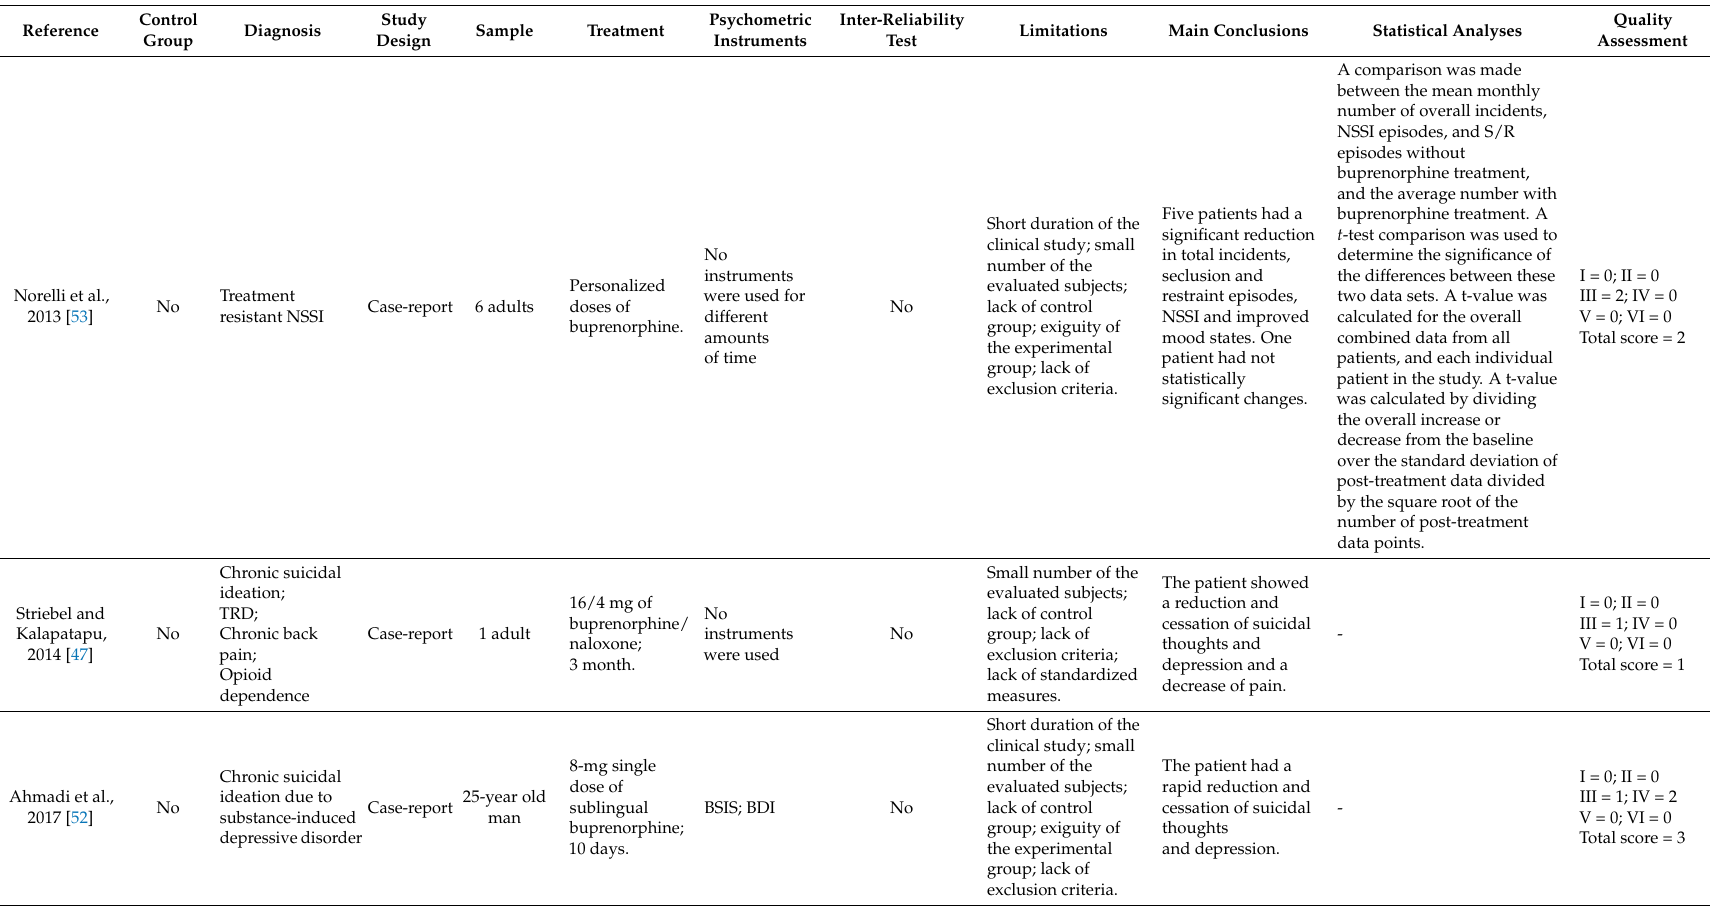
Table 1. Summary of the most relevant case-report studies concerning BUP and depression/suicidal behavior included in the present